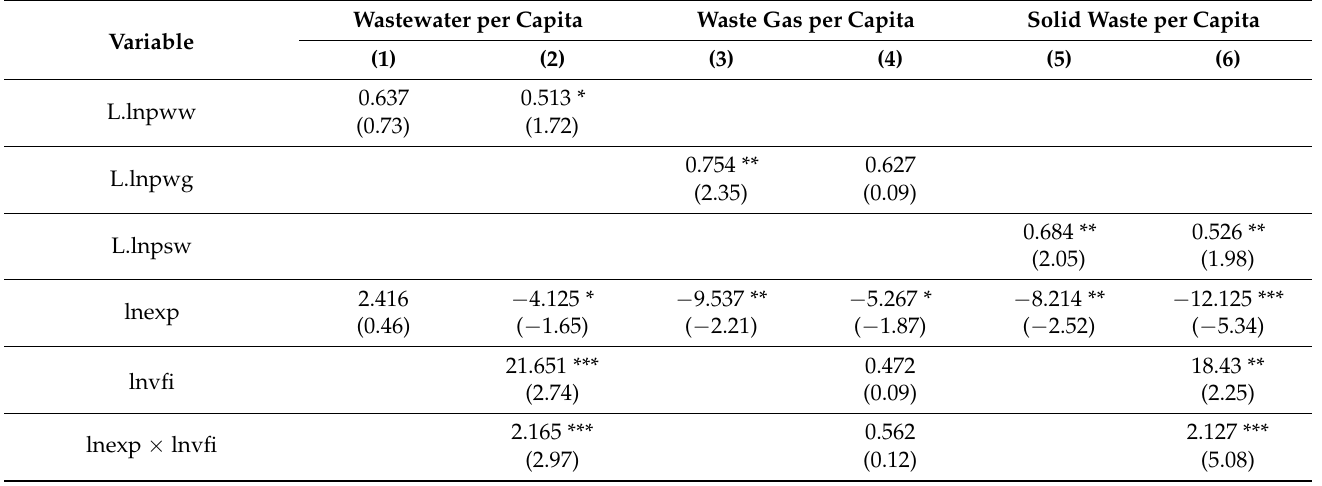
Table 5. Regression results of